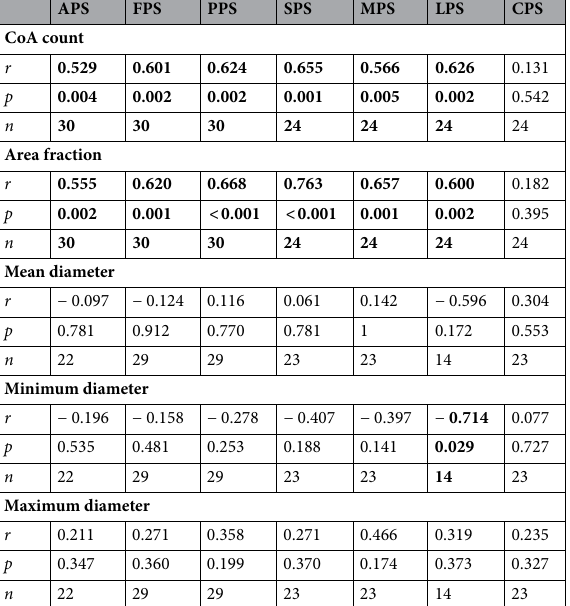
Table 1. Spearman’s Rho correlation of ranked CoA sequence with tested CoA parameters. Significant differences are indicated in bold. The listed p values are after adjustment for Type 1 error with FDR. APS alveus pial surface, FPS fimbria pial surface, PPS prosubiculum pial surface, SPS subiculum pial surface, MPS medial entorhinal cortex pial surface, LPS lateral entorhinal cortex pial surface, CPS collateral sulcus pial